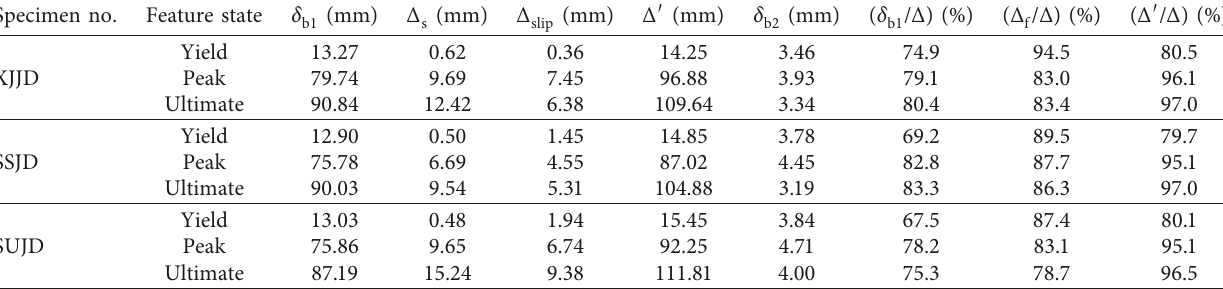
Table 9: Test results of the deformation.